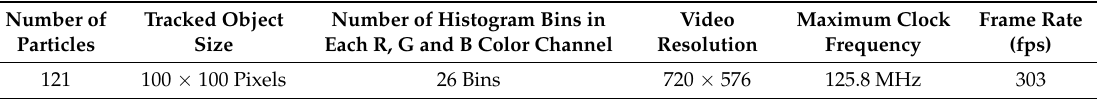
Table 4. Summary of selected parameter values and performance of our object tracking